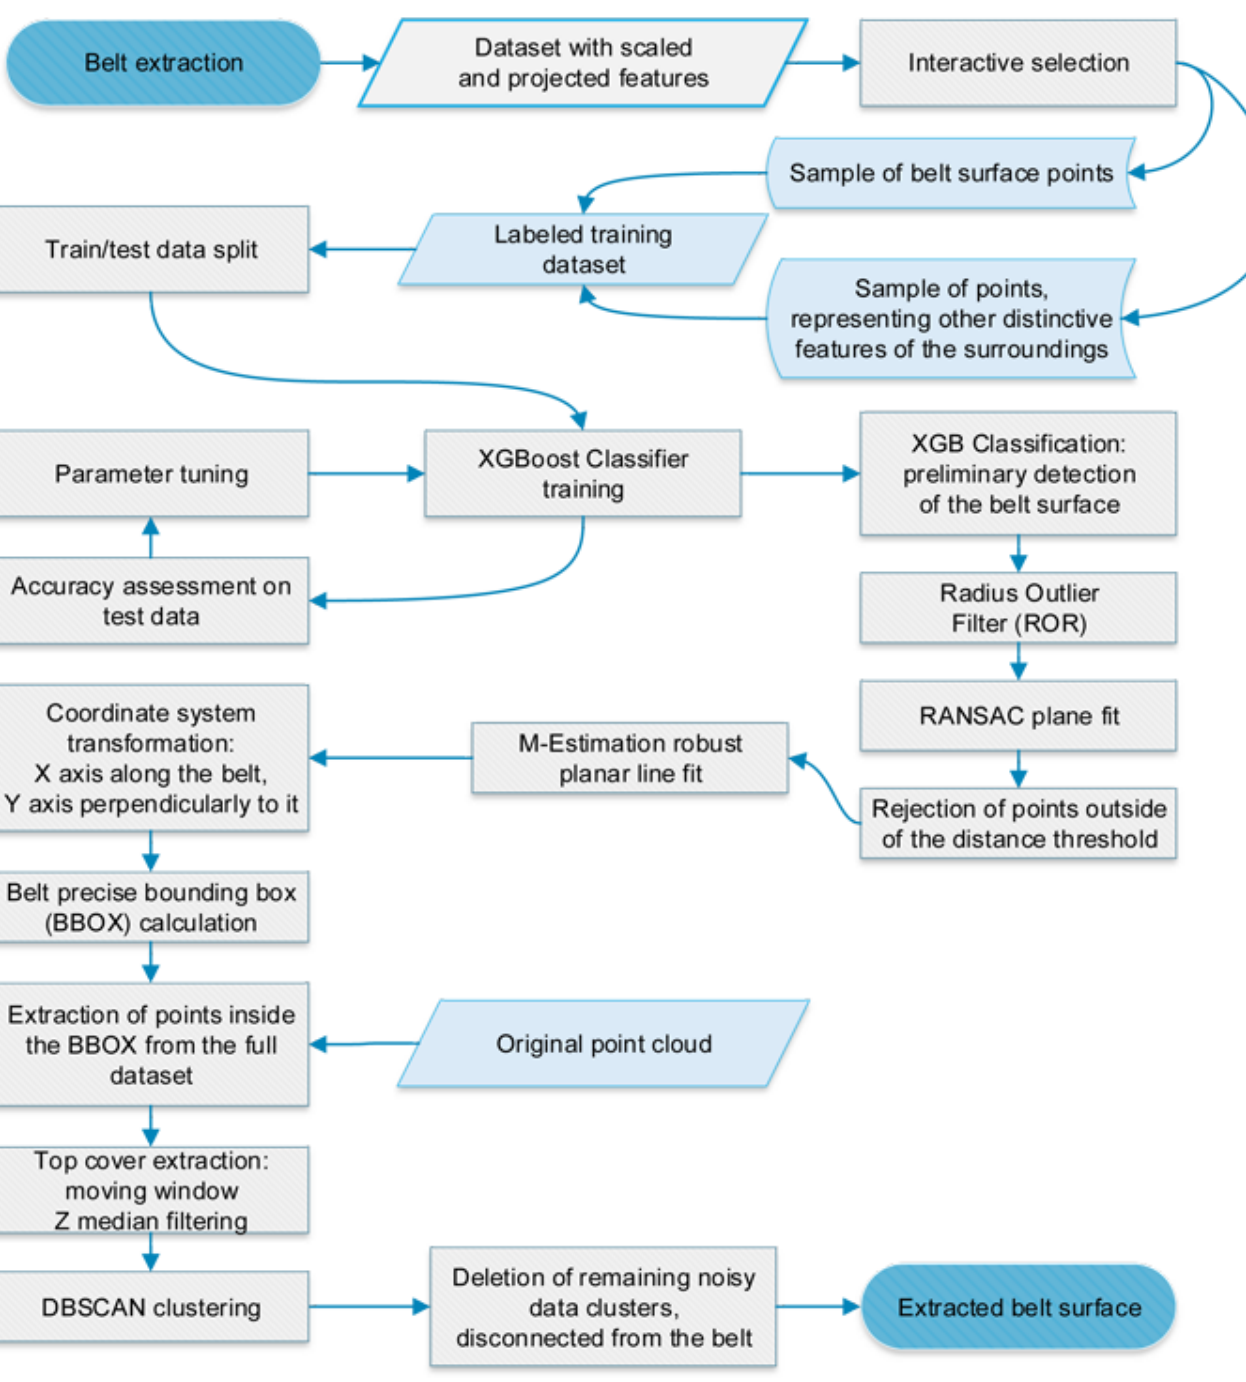
Figure 3. Workflow of belt extraction